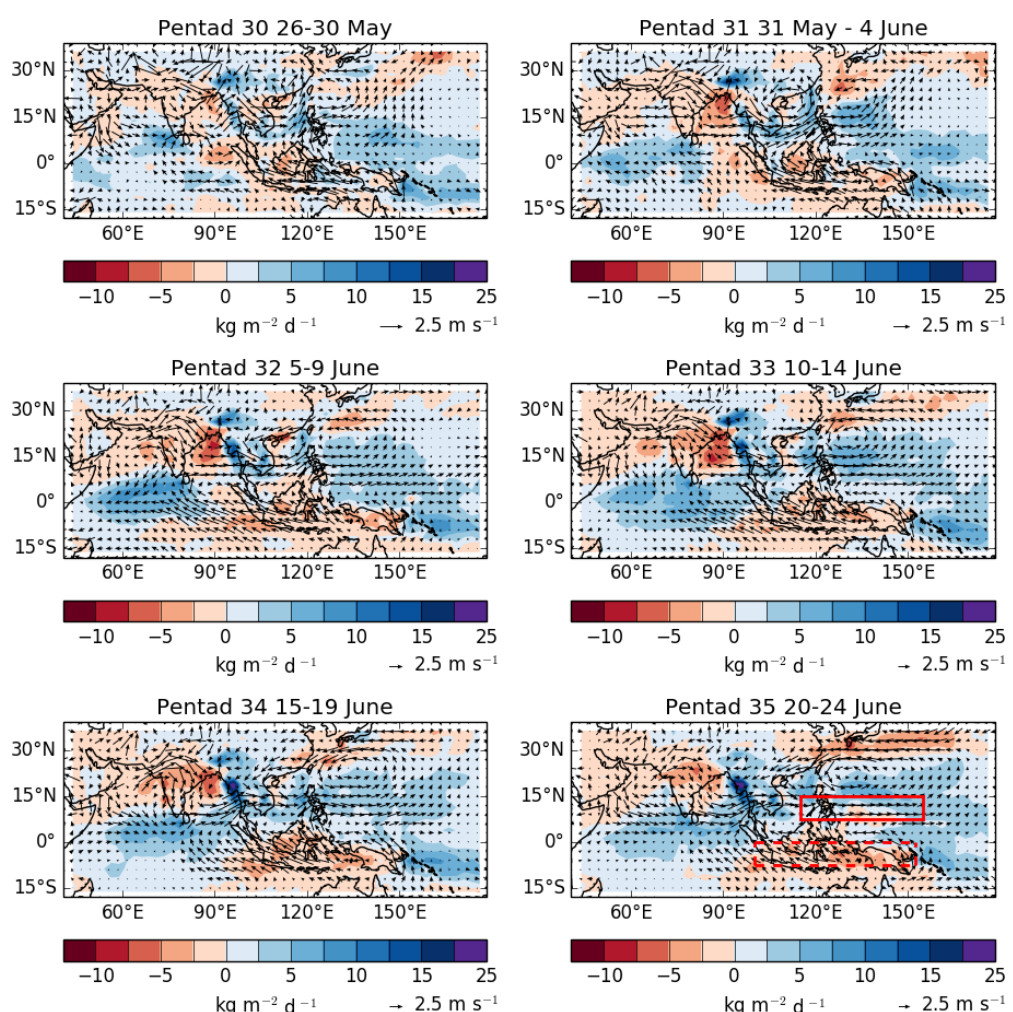
Figure 6. Development of climatological errors in 850hPa winds and precipitation (against ERA-I and GPCPv2), pentad by pentad after initialisation on 25 May. The solid red box indicates the “Philippines” region used Fig. 8c and in the nudging experiments. The dashed red box shows the “Indonesia” nudging